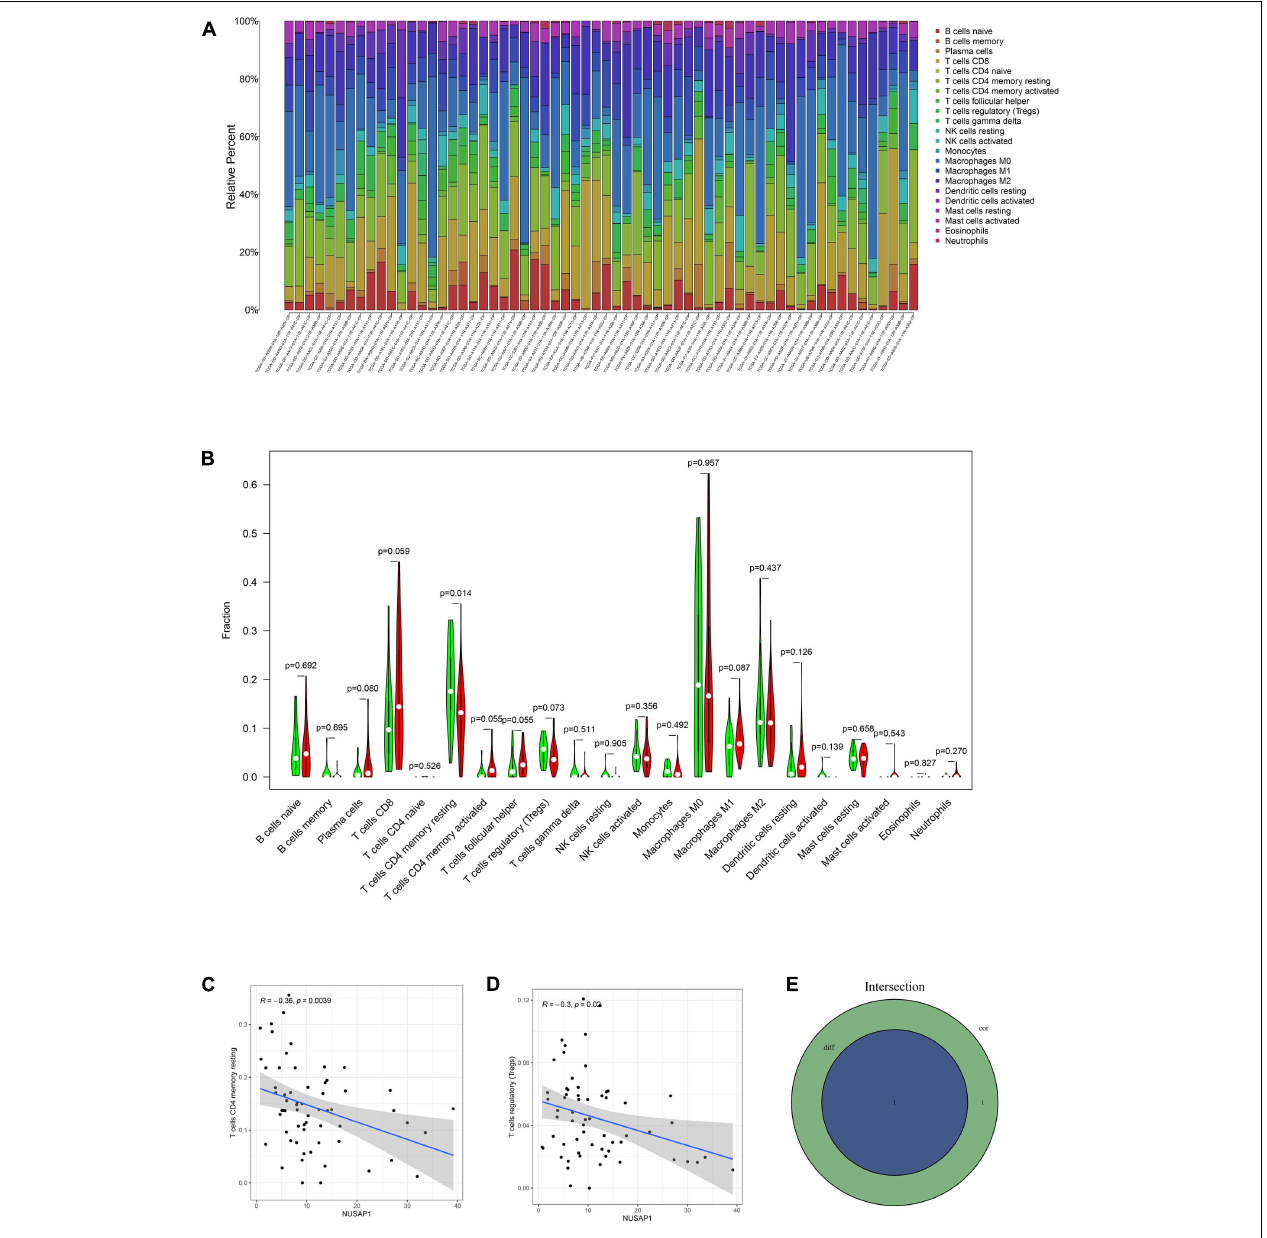
FIGURE 11 | Bar plot, violin plot, correlation diagrams, and Venn diagram. All pictures were drawn by HCC patients’ information in TCGA database. (A) Bar graph, which contained content of 22 immune cells in each sample. (B) Violin plot, which proved 22 immune cells whether they exhibited difference between high expression group and low expression group. (C) The correlation diagram between NUSAP1 and T cells CD4 memory resting. (D) The correlation diagram between NUSAP1 and T cells regulatory (Tregs). (E) Venn diagram, which was used to visualize the immune cells that were both meaningful in violin plot and correlation